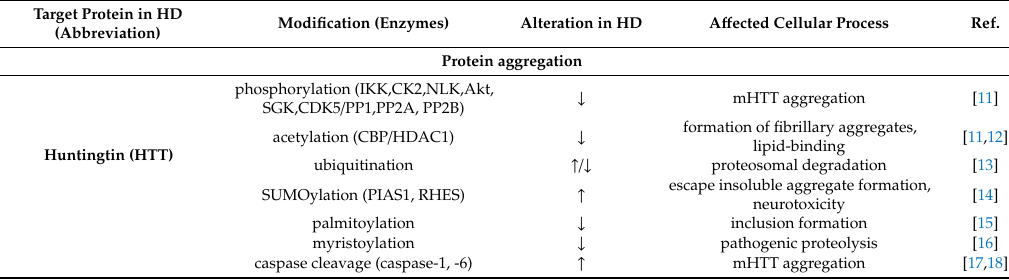
Table 1. Post-translational modification of e ff ector proteins in the signal transduction of Huntington’s disease